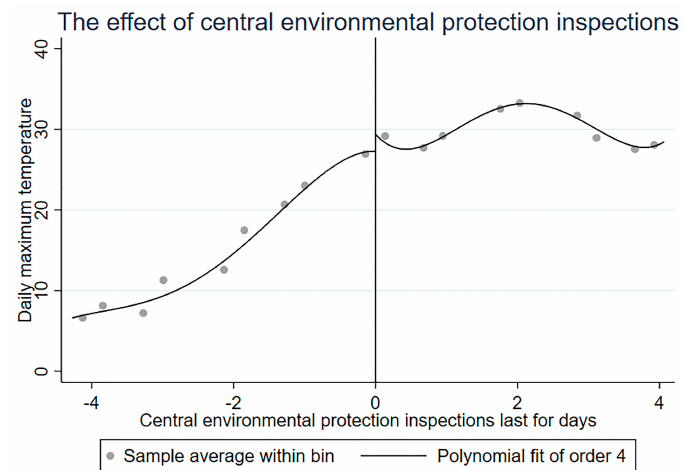
Figure 6. Smoothness hypothesis test chart.